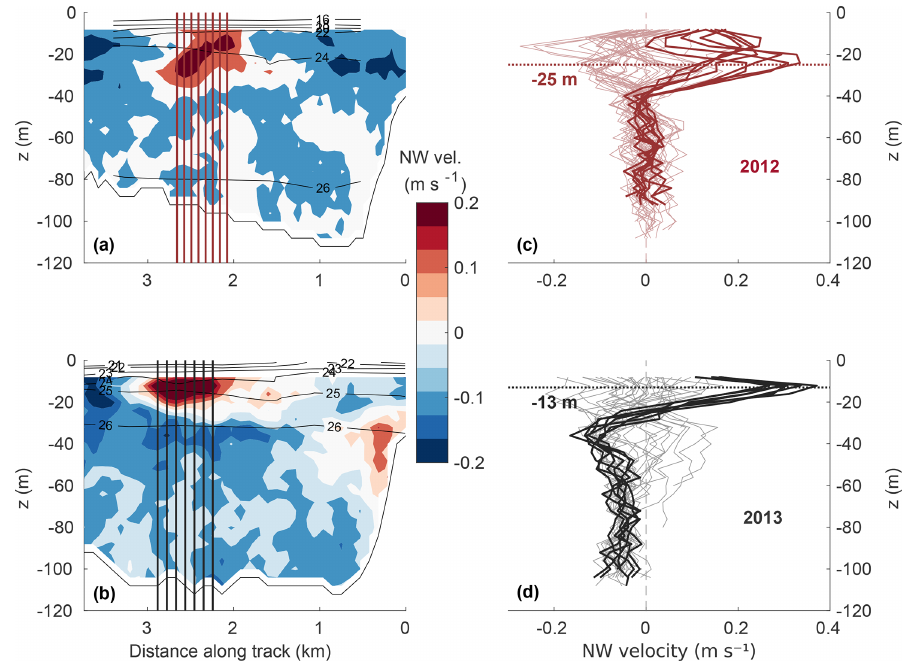
Figure 7. (a, b) Fjord water velocity transects and (c, d) velocity profiles from ADCP measurements taken in 2012 (a, c) and 2013 (b, d) parallel to and at a distance of 1.5km from the glacier front (see Fig. 2). Darker profiles in (a, b) correspond to the vertical straight lines shown in (c, d) that span the jet. The contour lines in (a) and (b) are isopycnals of